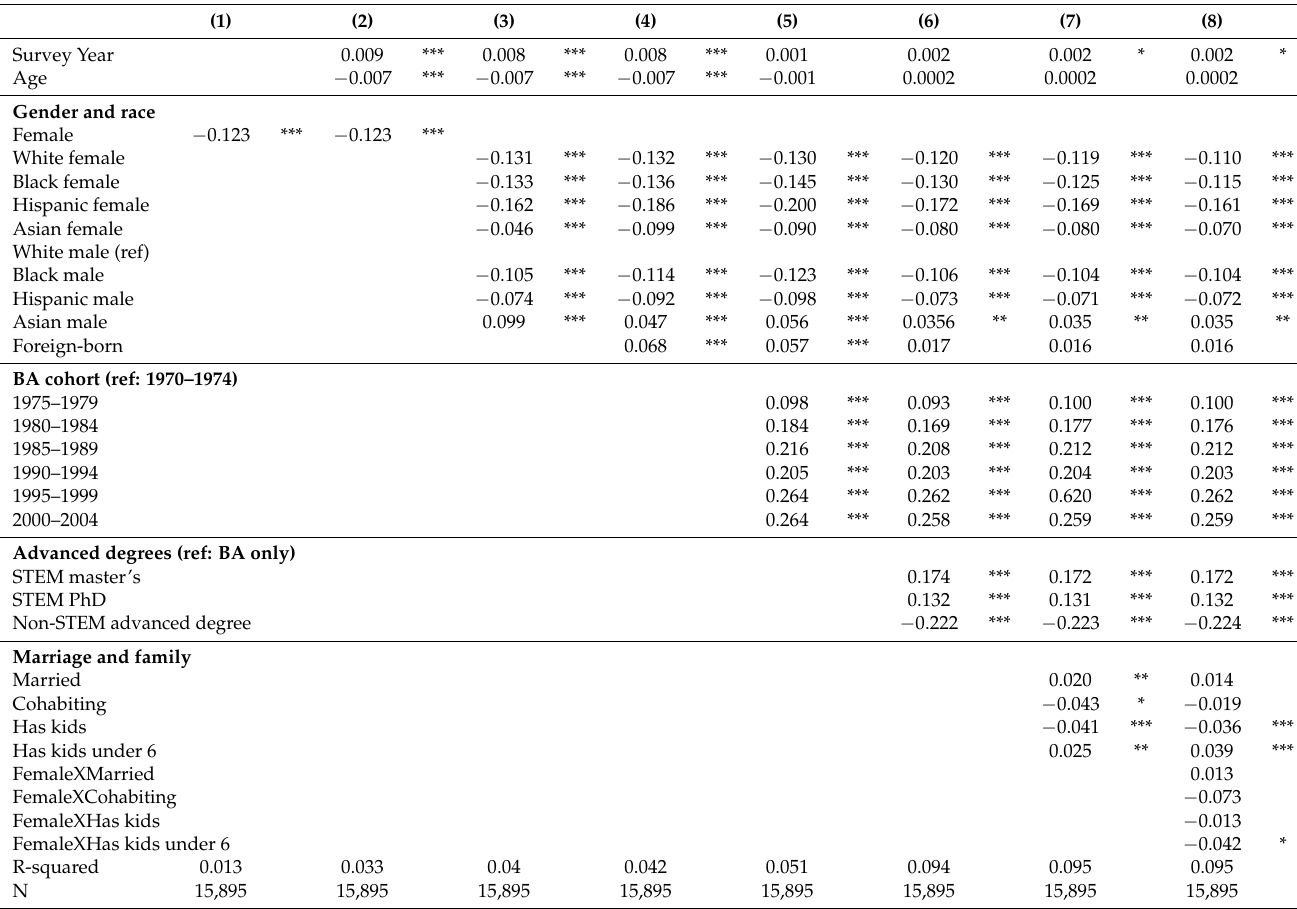
Table A2. Linear probability models predicting working in a computer or math science occupation: Computer science degree